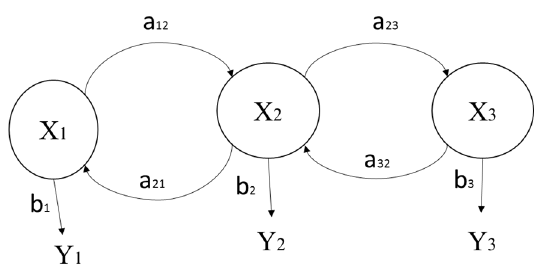
Figure 1. Conceptual diagram of the Hidden Markov Model.